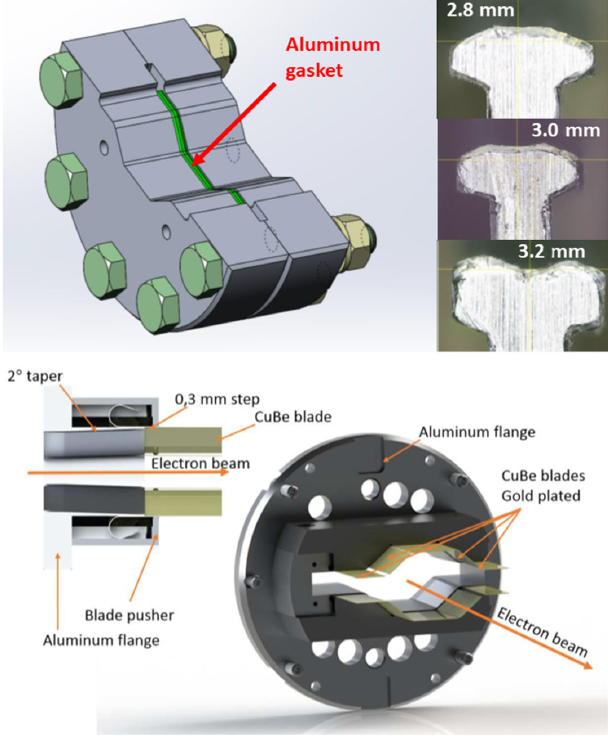
FIG. 2. Low impedance flange (top) and rf fingers (bottom) designs used at ESRF. The top right shows the optimization of the flatness of the